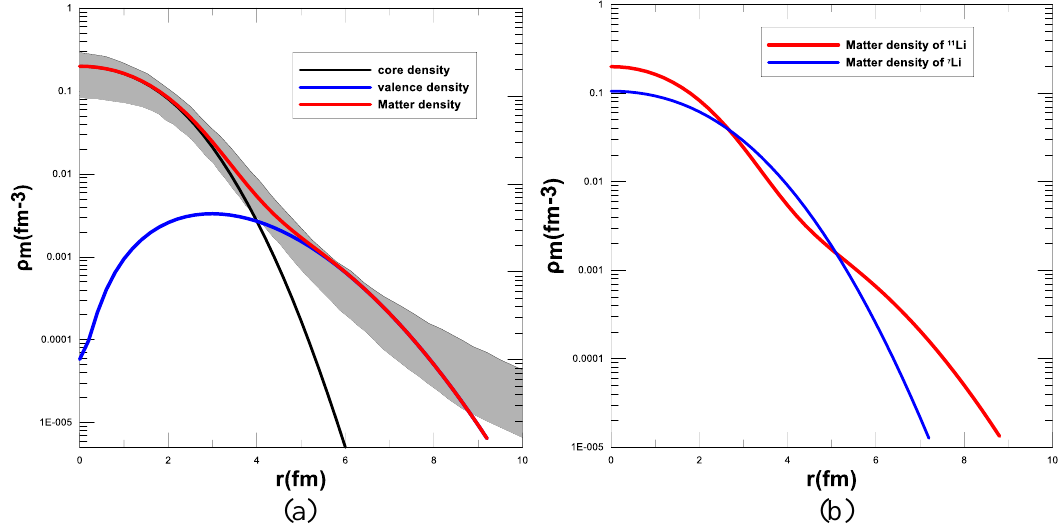
Figure 3: (a) The comparison between matter density distributions of 11 Li with that of experimental data, (b) The comparison between matter density distribution of 11 Li and 7